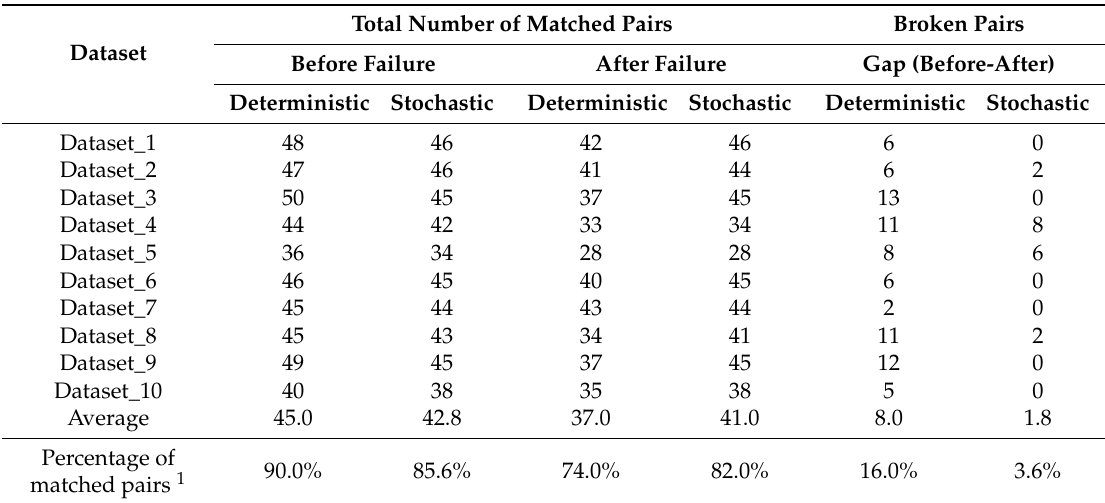
Table 4. Comparison of the number of matched pairs when the patient’s health deteriorates.